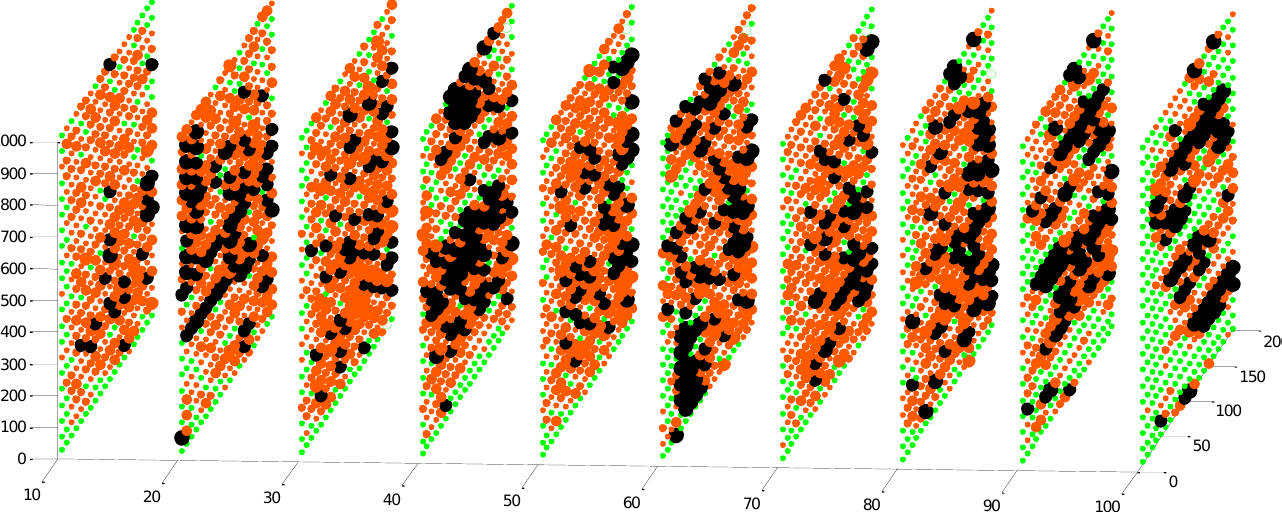
c on EEACL26 images, which is roughly “darker” than Fig. 9. Performance 36